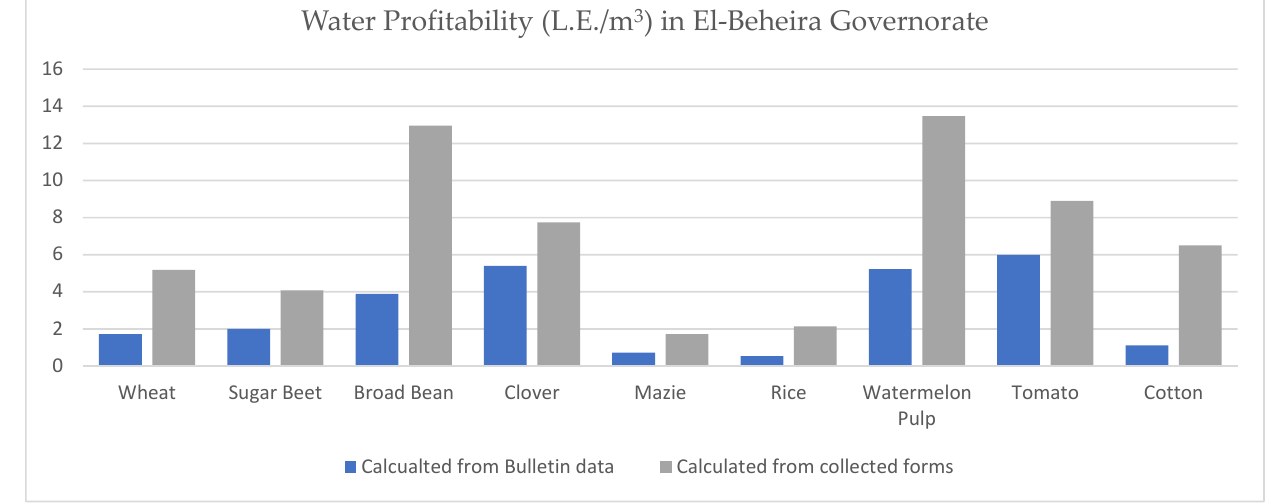
Figure 3. Water profitability for El-Beheira Governorate from Bulletin data compared to collected forms. Source: In blue, Ministry of Agriculture and Land Reclamation–Economic Affairs Sector’s